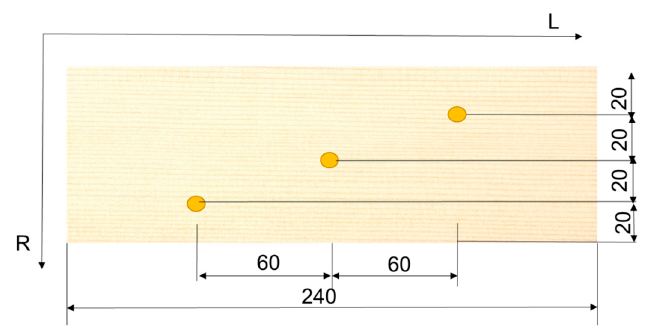
Figure 2. The color measurement location.